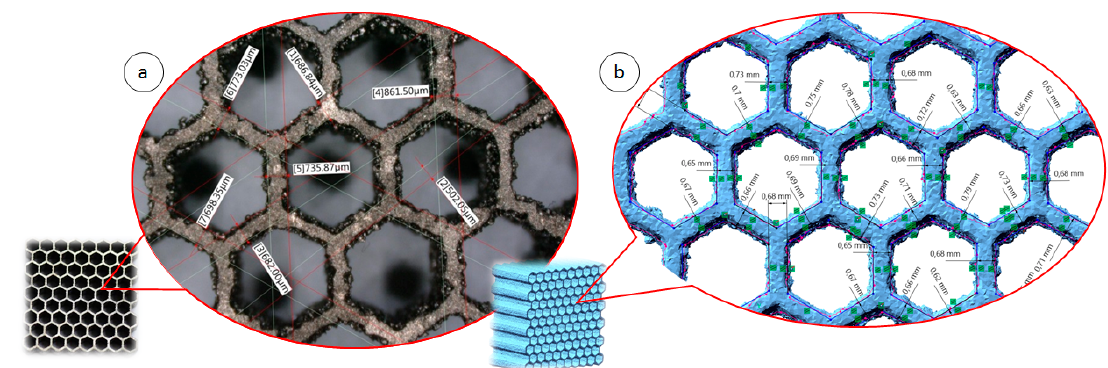
Figure 5. Geometrical evaluation of structure specimens: ( a ) with the application of optical microscopy, ( b ) based on a 3D model reconstructed from Computed Tomography (CT) data [56].